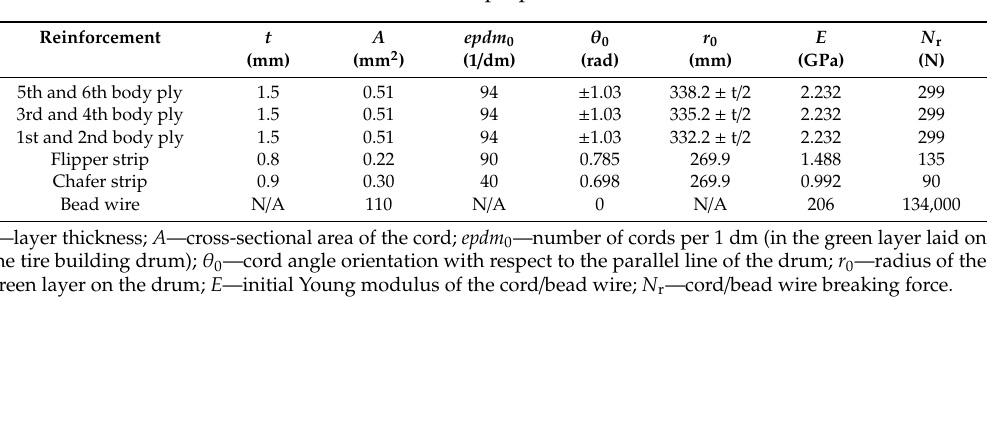
Table 1. Geometric and mechanical properties of bias tire